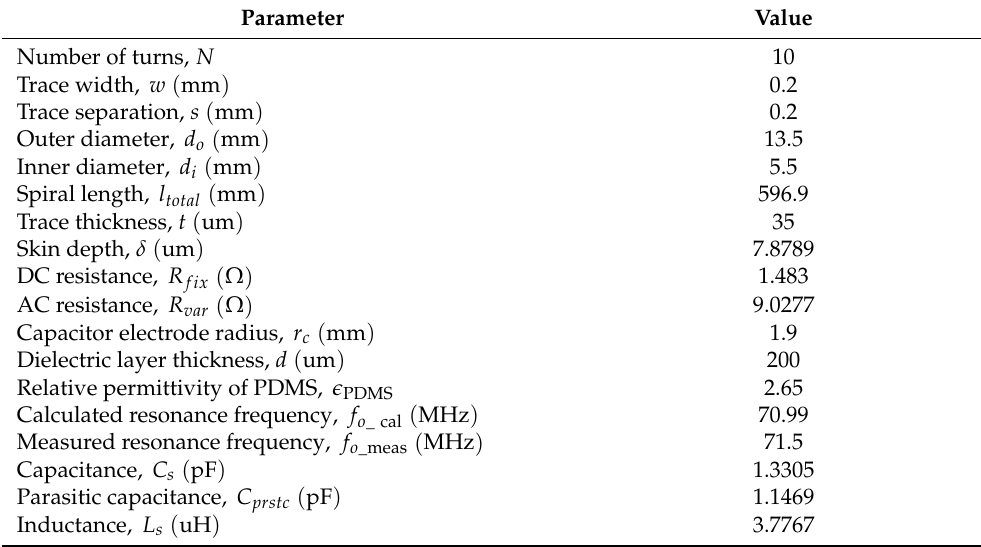
Table 1. The key design parameters and electrical characteristics of the implanted